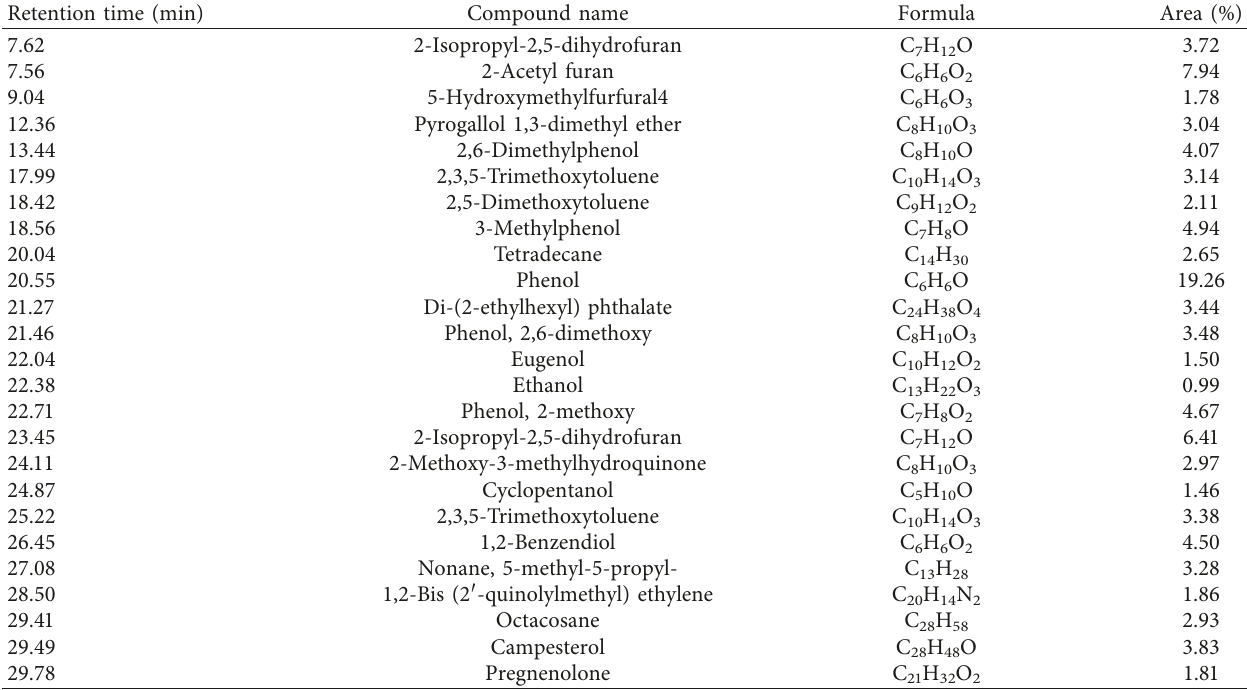
Table 3: GC-MS analysis of the bio-oil.